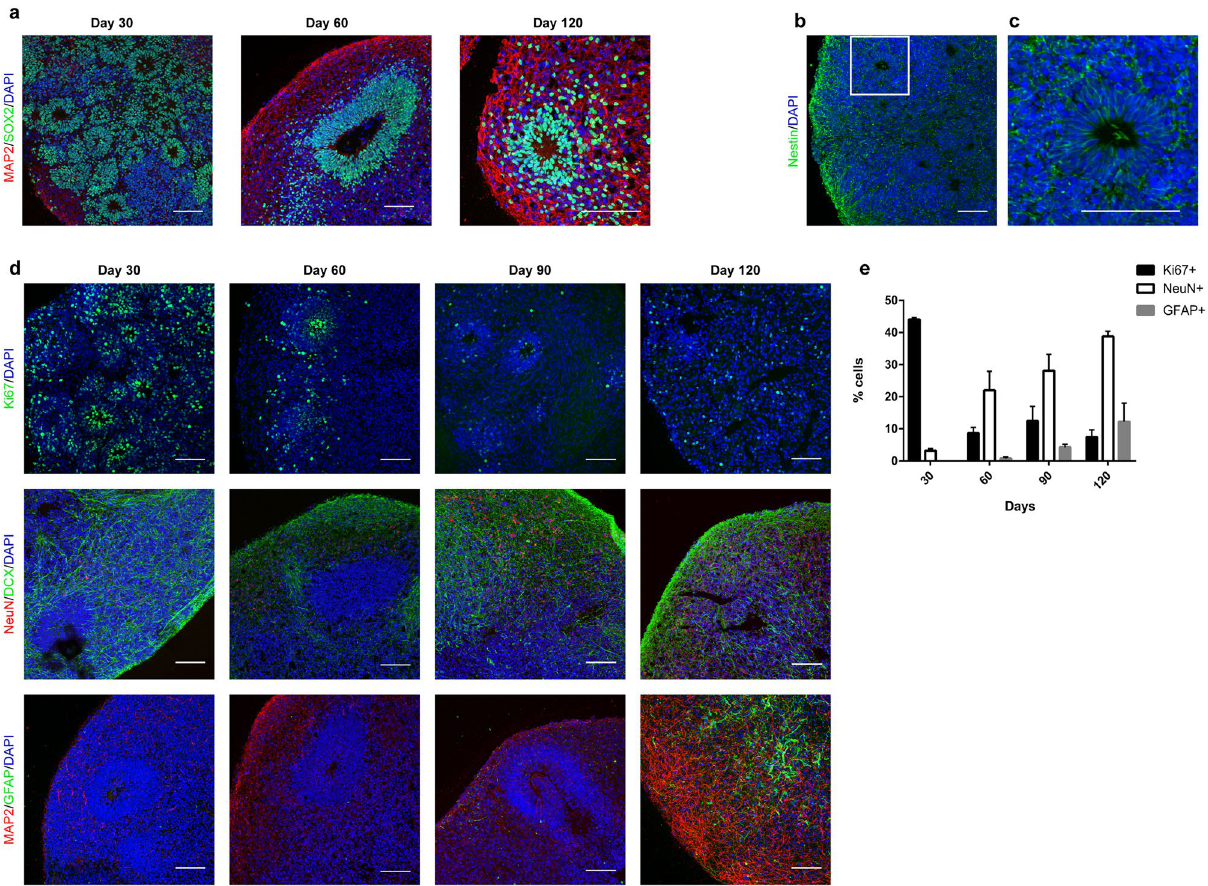
Figure 1. Neurogenesis and gliogenesis in cerebral spheroids. ( a ) Representative immunofluorescence images of cerebral spheroids stained for neuroectodermal cell (SOX2) and post-mitotic neuron (MAP2) markers after 30, 60 or 120 days of culture. Bars = 100 µm. ( b ) NSCs express the neural stem cell marker Nestin. A spheroid at day 30. Bar = 100 µm. ( c ) Enlargement of white square in ( b ) showing that Nestin-positive NSCs are radially organized in a neuroepithelium-like structure. Bar = 100 µm. ( d ) Representative immunofluorescence images of cerebral spheroids stained for neuroectodermal proliferative cell (Ki67), immature neuron (DCX), post-mitotic neuron (MAP2, NeuN) or glial cell (GFAP) markers after 30, 60, 90 and 120 days of culture. Bars = 100 µm. ( e ) Quantification of cells expressing specific markers for proliferation (Ki67), neurogenesis (NeuN) and gliogenesis (GFAP). Data represent mean ± SEM of 2–3 organoids/cell line, 3 different iPSC lines.